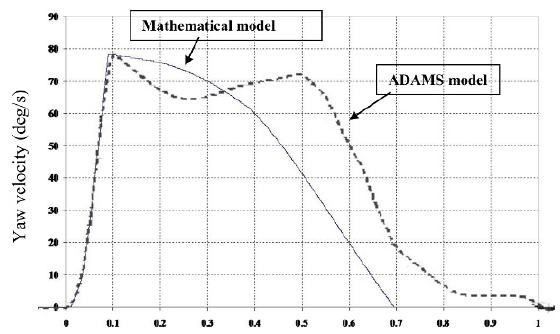
Figure 11. Yaw velocity of the vehicle body.